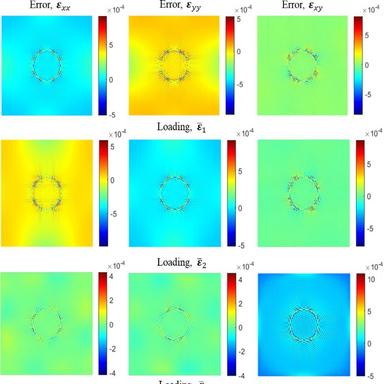
Errors of the strain predicted by RVE-net for the three loading conditions.